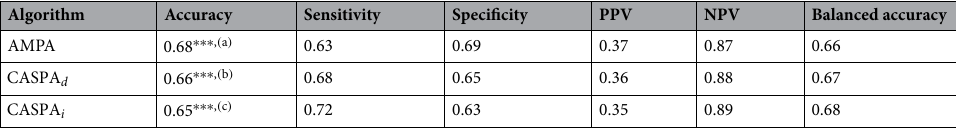
Table 2. Overall results of SDA-M-based error prediction in assembly. (a) p < 10 − (c) p < 10 − 14 .